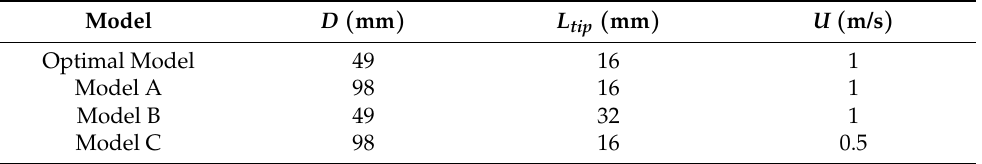
Table 4. Specifications for Different Models Subject to Finite Element